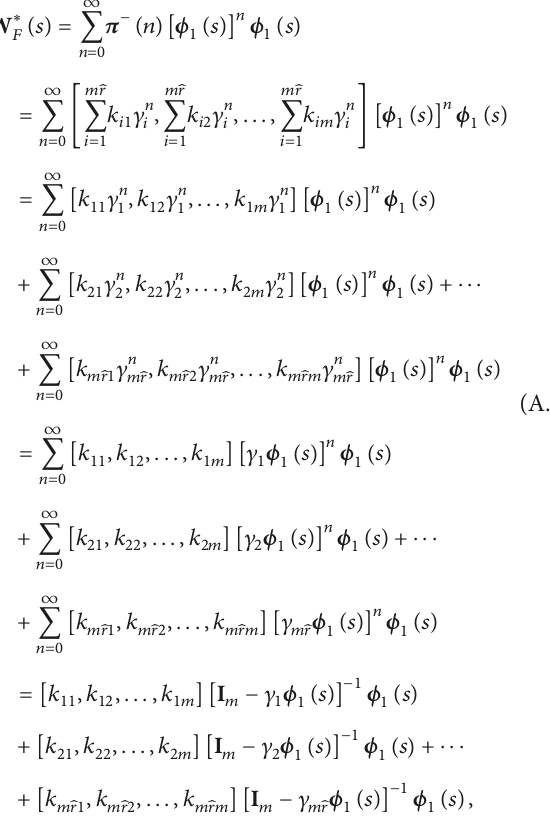
Figure 5: 𝑥 versus p.d.f.